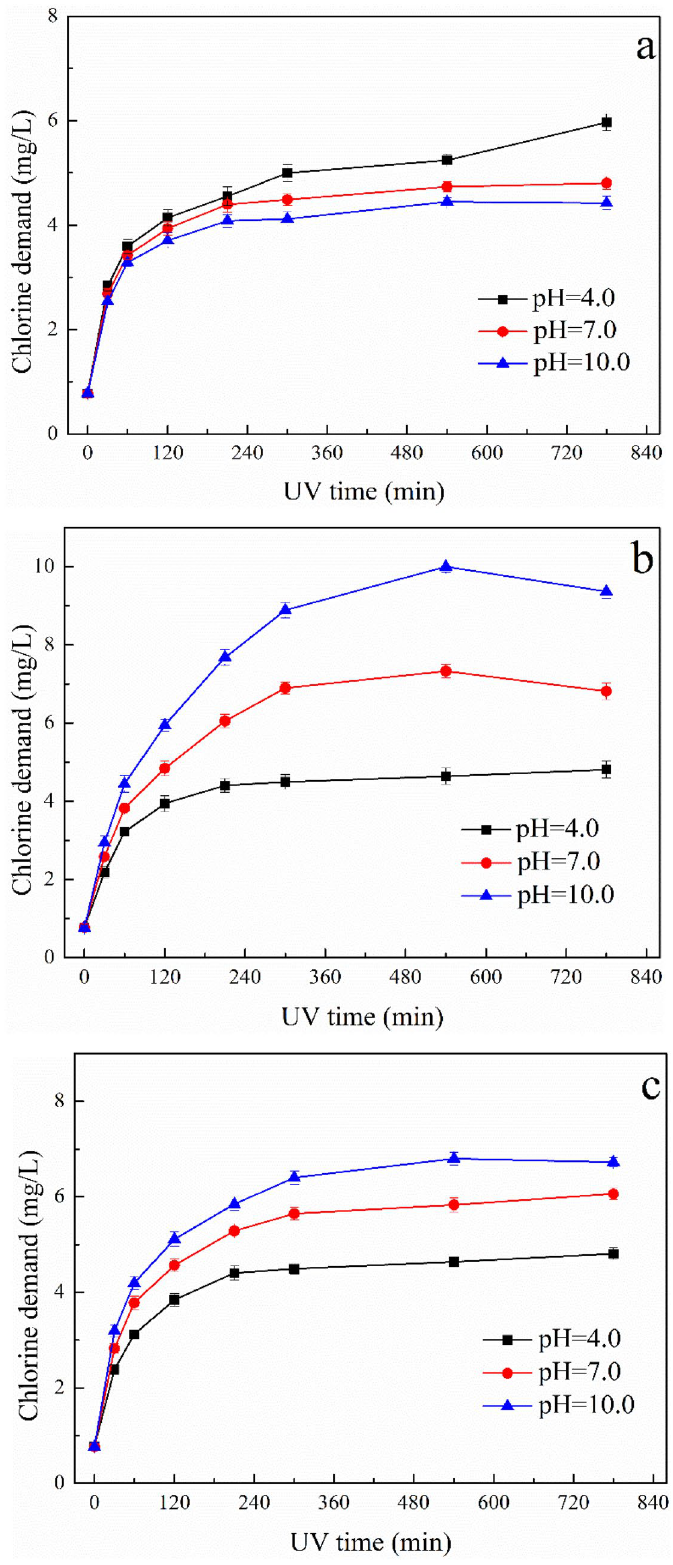
Figure 8. The chlorine demand of oxidized ATZ solutions after 24 h chlorination, ( a ) UV process; ( b ) UV/ H 2 O 2 process; (c) UV/TiO 2